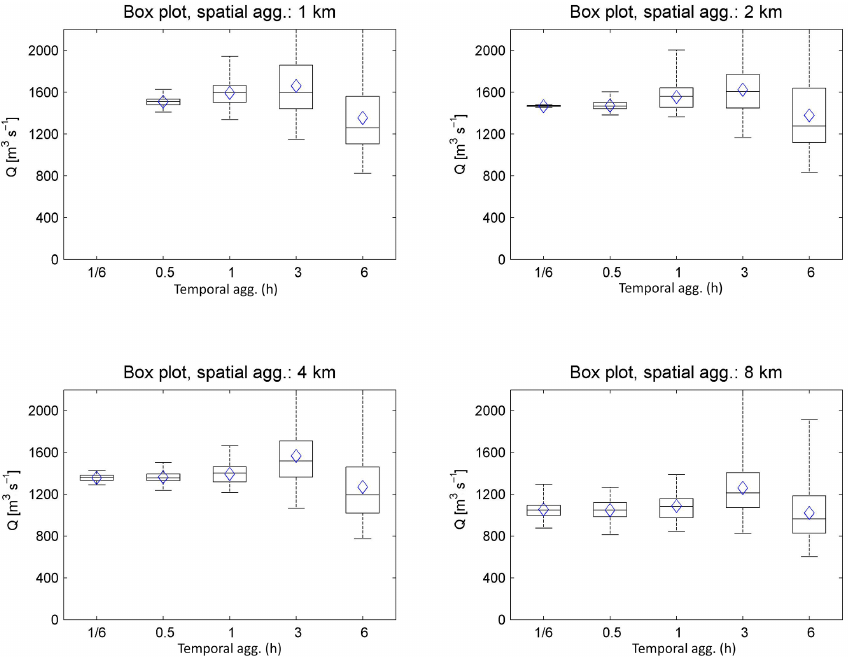
Figure 6. Passerella Firpo reference section, area: 93km 2 . Box plot of the peak flow generated by the FFF. On y axis the peak flow is reported; on x axis the temporal aggregation scales (RSt) are reported. Diamonds represent the peak flow of the reference hydrograph. Each subpanel shows results for a different spatial aggregation scale (RSs).